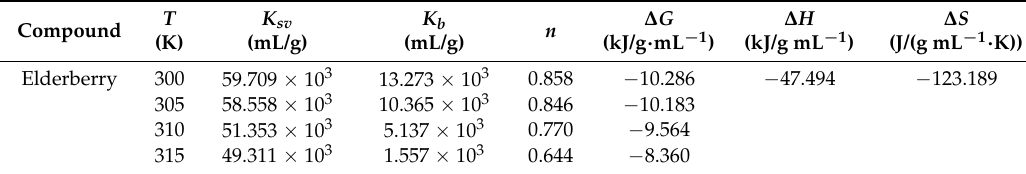
Table 6. Quenching ( K sv ) and binding ( K b ) constants and thermodynamic parameters ( n , ∆ G , ∆ H and ∆ S ) for elderberry extract and human serum albumin at different temperatures. Standard deviations (mean value of three independent experiments) were lower than